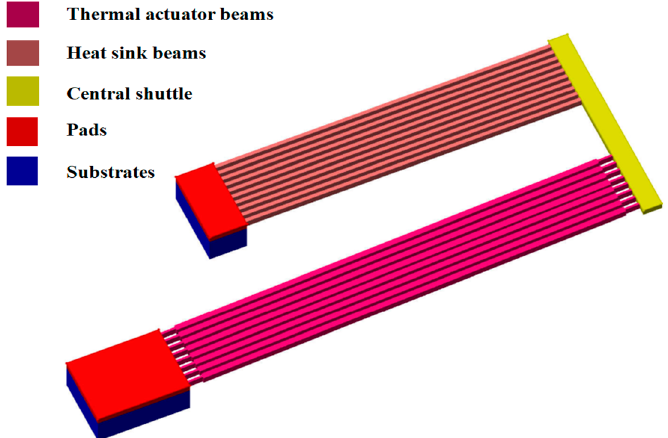
Figure 6. Connection of heat sink beams to the substrate and the actuator shuttle. Heat sink beams are subject to transverse loading that produces significant bending